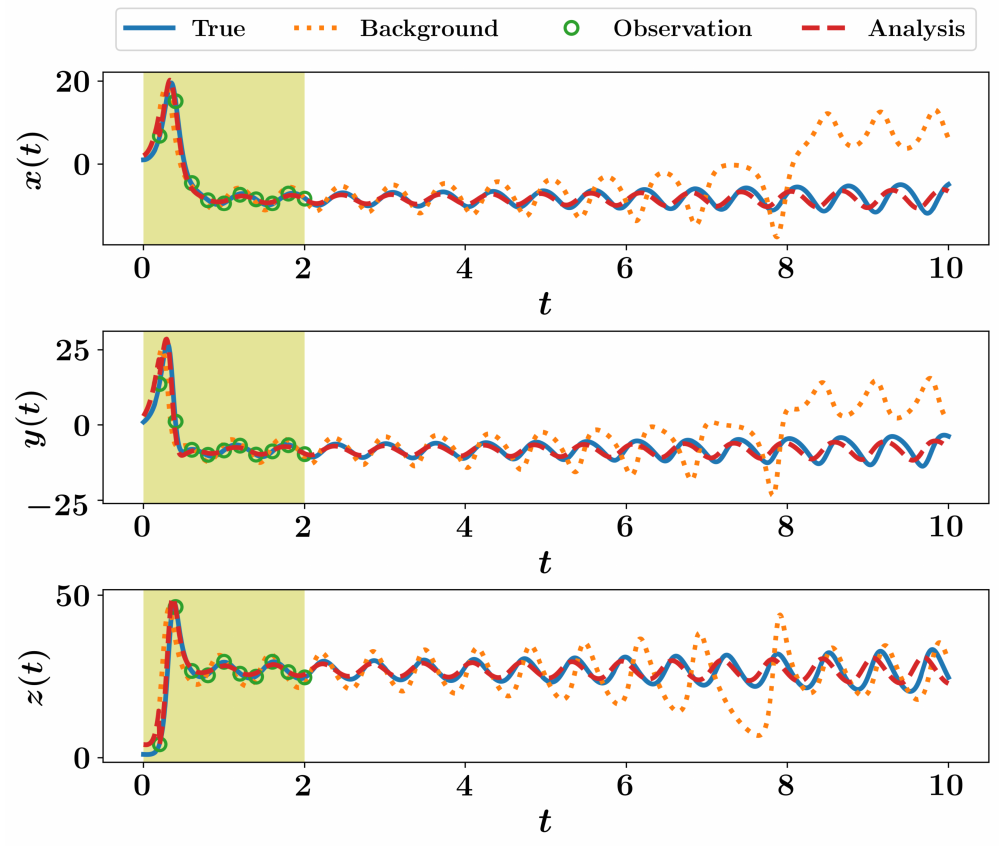
Figure 5. EnKF results for the Lorenz 63 system with virtual